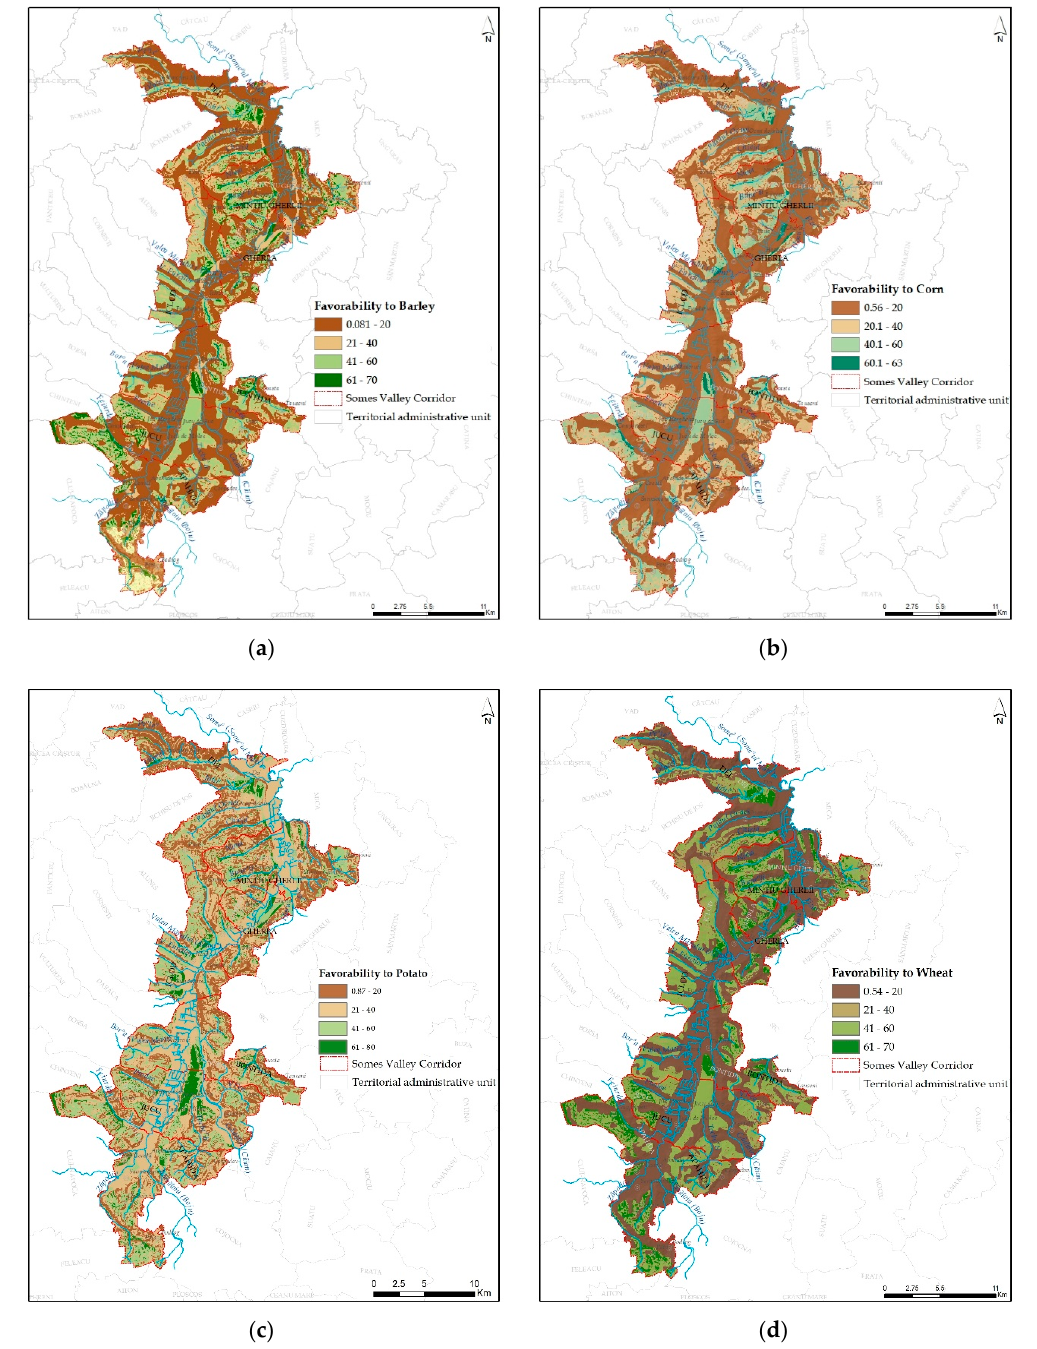
Figure 4. ( a ) Land favourability for barley. ( b ) Land favourability for corn. ( c ) Land favourability for potato. ( d ) Land favourability for